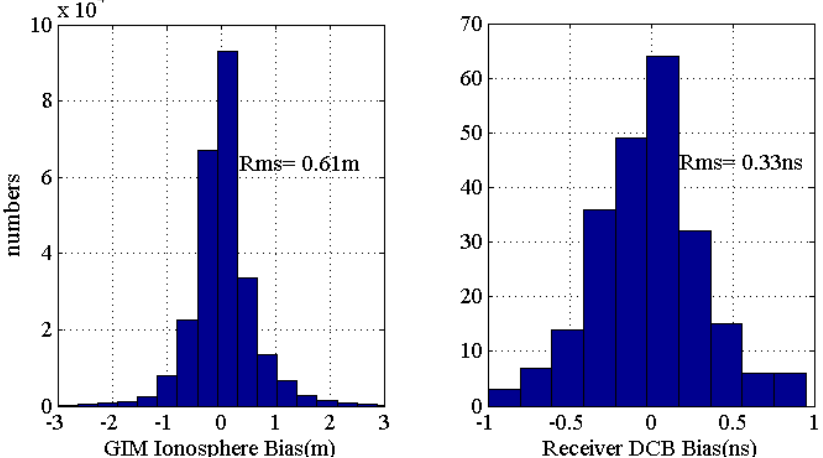
Figure 3. Histogram showing the differences of slant ionospheric delays and receivers’ DCB between IGS published results and IC-PPP + DCB derived results at the selected 300 IGS